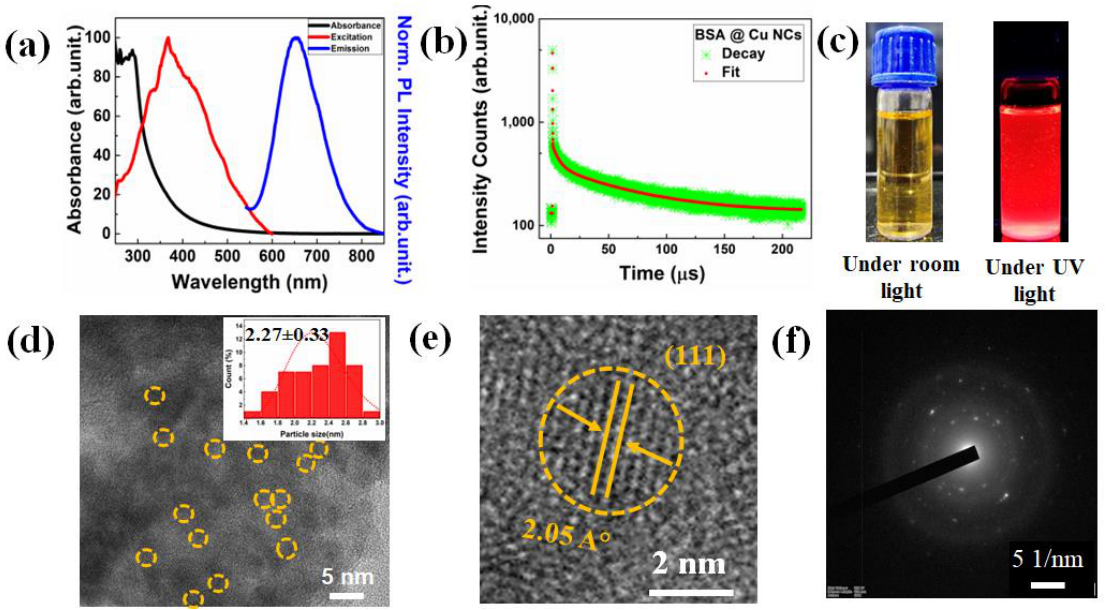
Figure 1. ( a ) Optical characteristics of BSA-Cu NCs, including absorbance, excitation and emission spectra (black, red and blue color line). ( b ) Time-resolved PL radiative decay patterns of Cu NCs, showing a three-exponential decay. ( c ) Digital photographs were captured while these Cu NC solutions were being exposed to the room light and under 365 nm UV light irradiation. ( d ) The inset histogram analysis and yellow-colored short, dotted lines on the low-resolution HRTEM image of Cu NCs indicates that the average size is ~2.27 ± 0.33 nm. ( e ) The high-resolution image of BSA-Cu NCs revealed the Cu (111) plane with 2.05 A° of d-spacing. ( f ) The SAED patterns confirmed the low crystalline nature of Cu NCs due to their ultrasmall size.